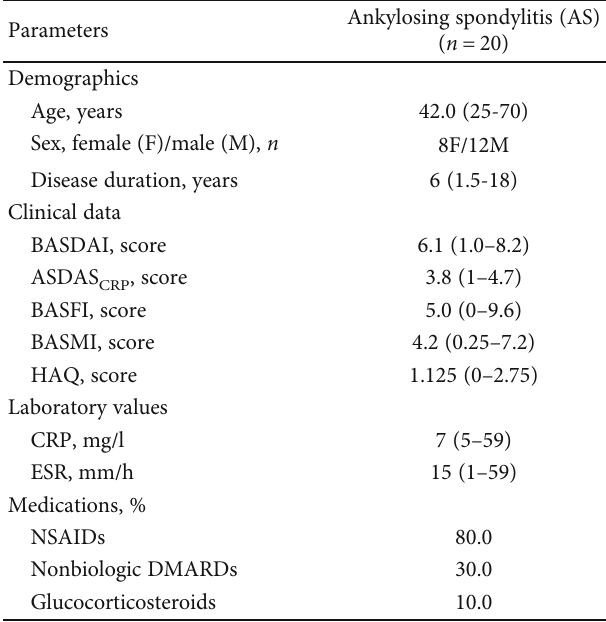
Table 1: Demographic and clinical characteristics of the patients.